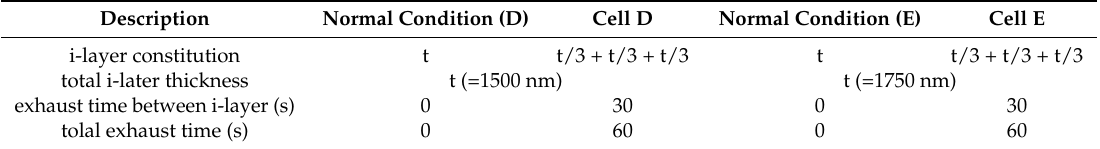
Table 2. Comparison of different i- µ c-Si:H thickness (1500/1750 nm) SEG processes with cell D and normal-condition cell D, and cell E and normal-condition cell E. Single evacuation times of SEG and total exhaust time of